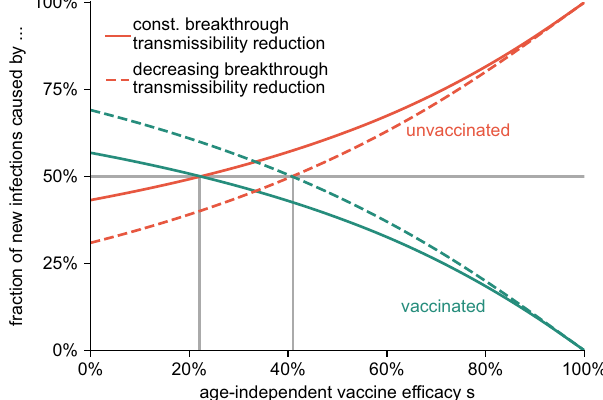
Fig. 3 Fraction of new cases caused by the unvaccinated and vaccinated population for varying age-independent vaccine ef fi cacy s . We consider an optimistic scenario with constant r = 0.1 and b = 3/2 (solid lines), and a pessimistic estimation in which r and b decrease according to r = s /10 and b = s /2 + 1 (dashed lines). As long as s remains larger than approximately 22% (optimistic, r 0 ¼ 40 % 0 ) or 41% (pessimistic, r 0 ¼ 20 % ), the unvaccinated minority still causes the majority of infections, see also Supplementary Methods, Sec. 1.3.1 and Sec.